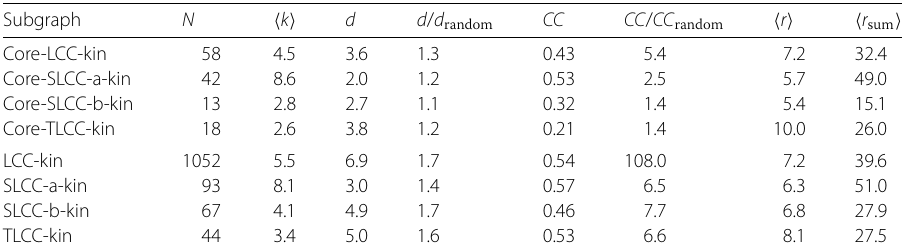
Table 1 Parameters describing the structure of the subgraphs in the network of kins Subgraph N (cid:2) k (cid:3) d d / d random CC CC / CC random (cid:2) r (cid:3) (cid:2) r sum (cid:3) Core-LCC-kin 58 4.5 3.6 1.3 0.43 5.4 7.2 32.4 Core-SLCC-a-kin